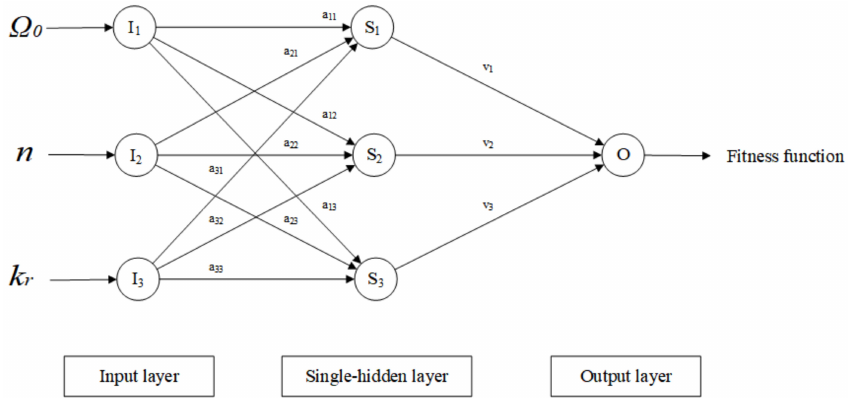
Figure 1. A single implicit layer ELM neural